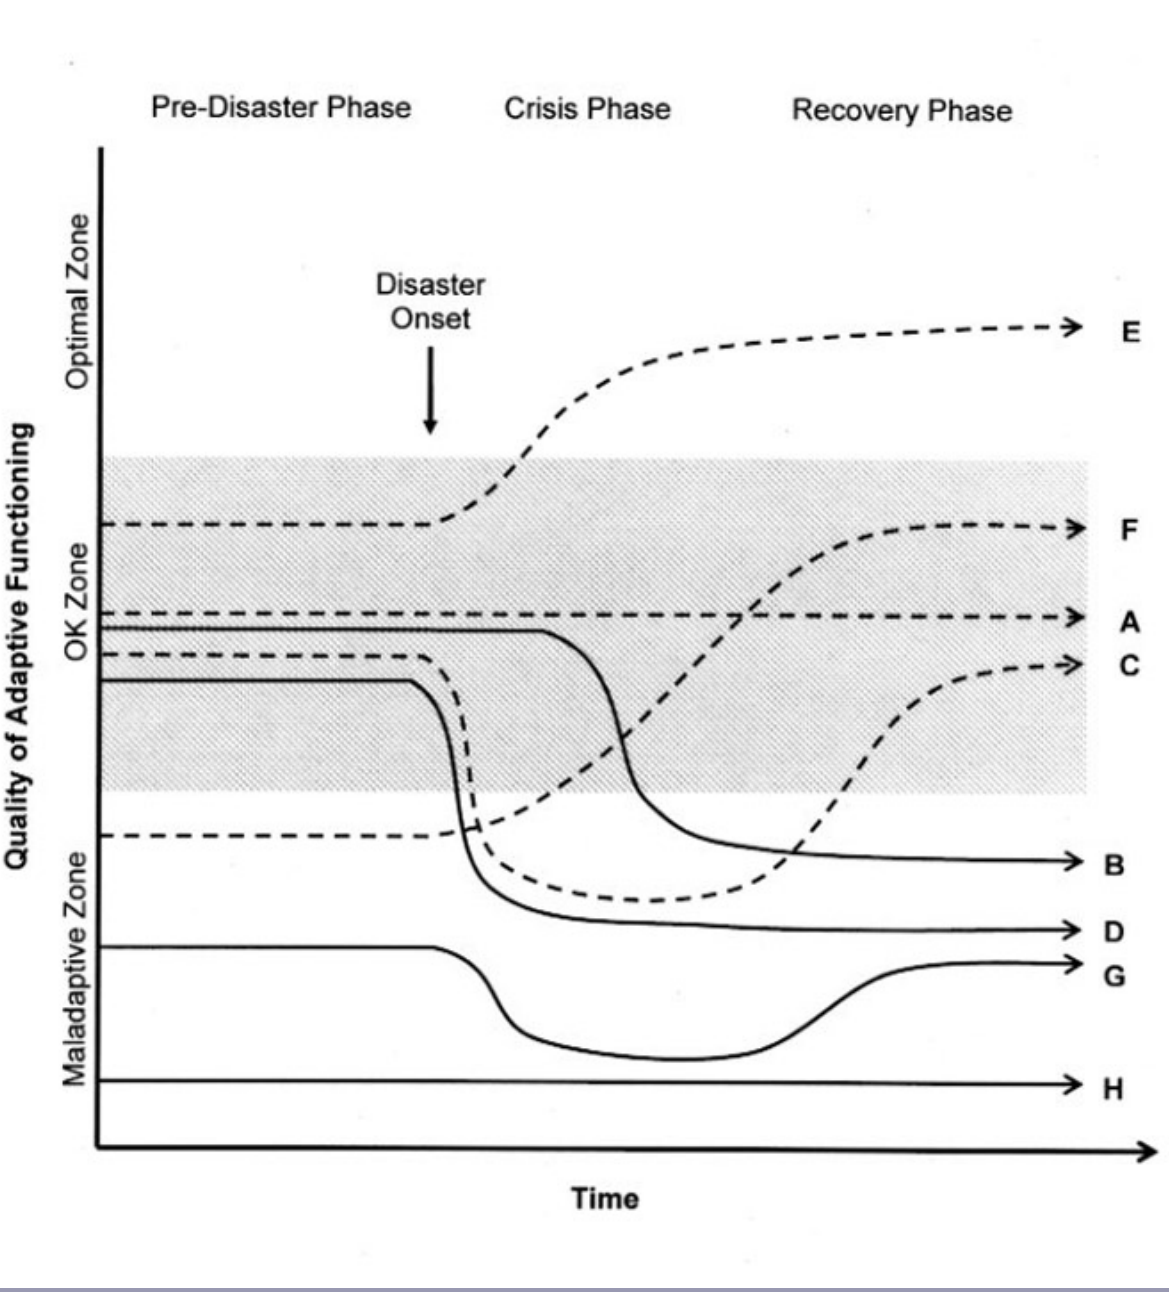
Fig. 1 . Examples of adaptive and maladaptive patterns in relation to an acute-onset disaster. Overall patterns reflecting resilience are shown with dashed lines. A = resistance, B= delayed breakdown, C = normal response and recovery, D = breakdown without recovery, E and F = positive transformation from higher and lower starting levels of adaptive functioning, G = persistent maladaptive pattern with disaster-related dip in functioning, and H = unresponsive maladaptive pattern, possibly indicating a floor